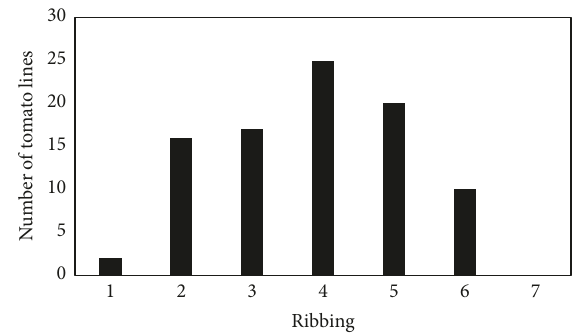
Figure 9: Distribution of ninety-one fresh-market tomato geno- types based on ribbing on fruits. The scale ranging from 1 to 7 with 1 being no or very weak ribbing and 7 being the